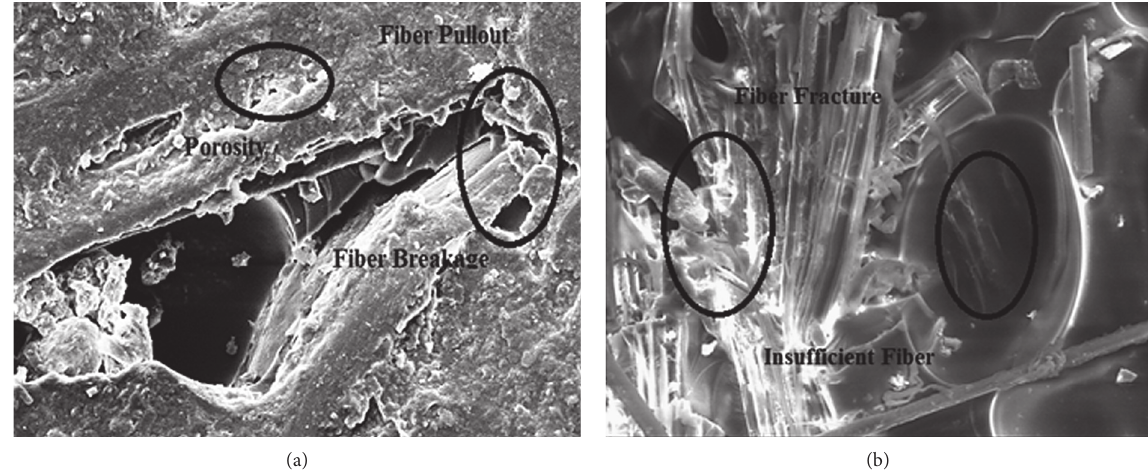
Figure 5: SEM images: (a) 5% wt. of snake grass fiber-reinforced composite; (b) 10% wt. of snake grass fiber-reinforced